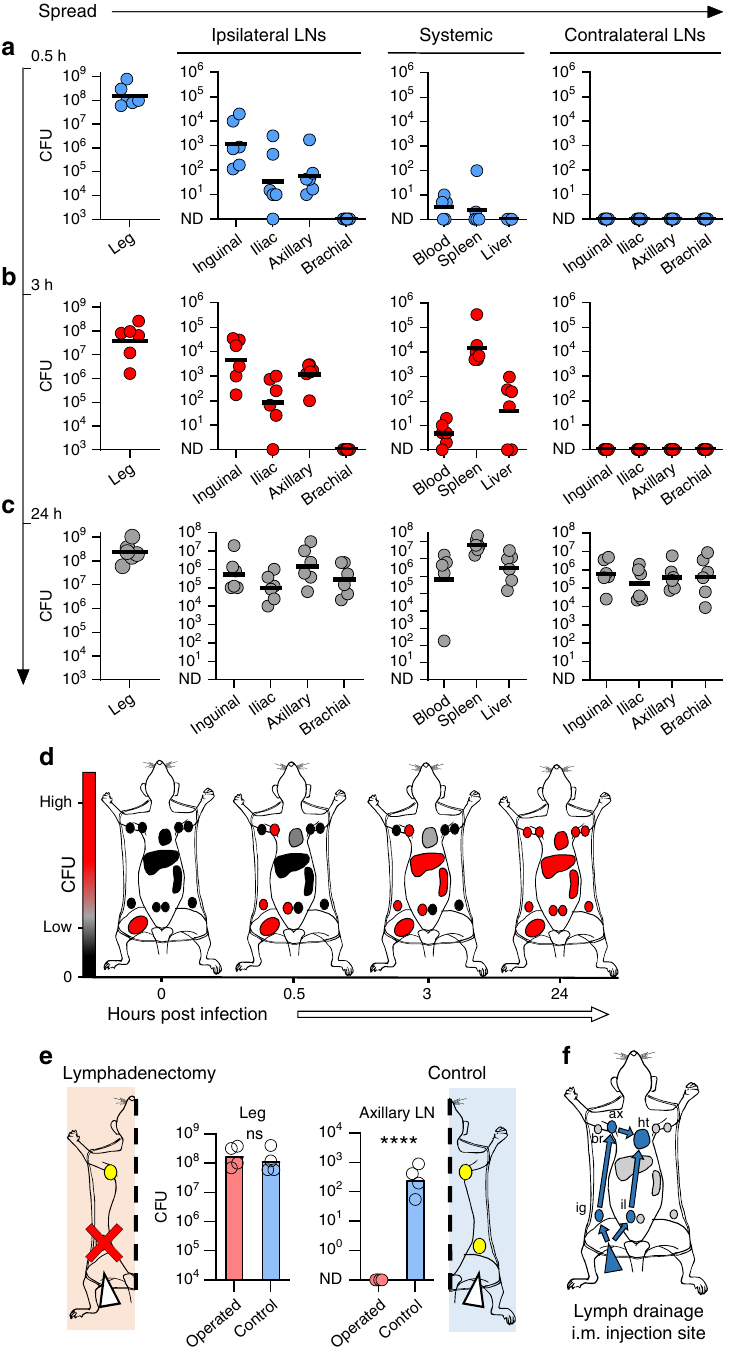
Fig. 1 S. pyogenes access systemic circulation via lymphatics. a – c S . pyogenes (H598) recovered from the hindlimb infection site, lymph nodes, and systemic organs of FVB/n mice 0.5h (blue circles, a ), 3h (red circles, b ), or 24h (grey circles, c ) after intramuscular infection with 10 8 CFU. Symbols represent individual mice, n = 6 per group, lines indicate geometric means. d Schematic summarising representative time course of transit of S. pyogenes from the hindlimb following intramuscular injection of hypervirulent S. pyogenes , organs listed in f. Black indicates 0 CFU; grey, low CFU; and red, high CFU counts. e Recovery of S. pyogenes from hindlimb infection site and ipsilateral axillary lymph nodes 1h after intramuscular infection with 10 8 CFU in FVB/n mice, with (red bars or red circles) or without (blue bars) surgical removal of the draining ipsilateral inguinal lymph node prior to infection. Symbols represent individual mice, n = 4 per group, bars indicate geometric means. **** p ≤ 0.0001; ns, p >0.5: Two-tailed Student ’ s t-test performed on log10-transformed data. f Schematic of lymphatic drainage route from hindlimb following intramuscular injection of Evans Blue dye, indicated by blue arrows and colouring: ig, ipsilateral inguinal node; il, ipsilateral iliac node; ax, ipsilateral axillary node; and ht, heart (via subclavian vein); br, ipsilateral (non-draining) brachial node. See also Supplementary Figs. 1 and 2. CFU are per ml of blood, per g of liver, per leg, or per